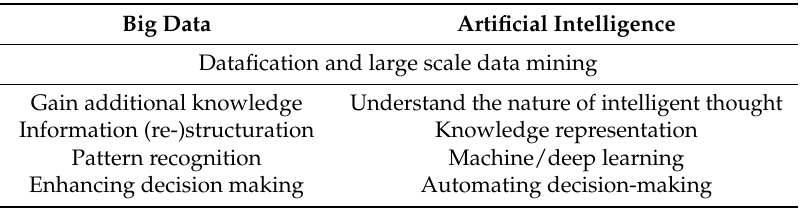
Table 1. General characteristics of big data and artificial intelligence